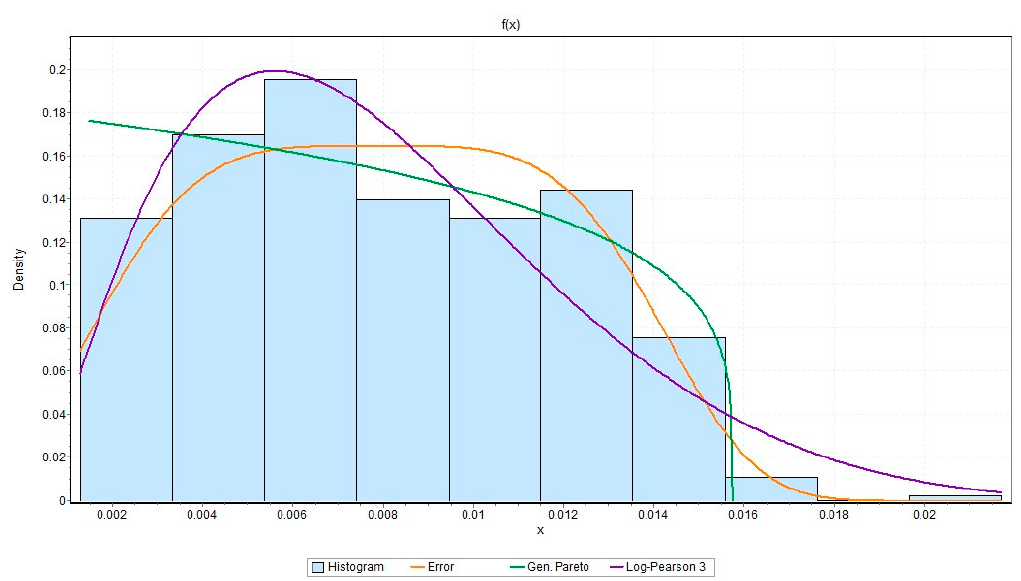
Figure 3. The empirical PDF and the PDF of the three best fitted three-parameter distributions of c 1 for IBP with T cl = 4 years.